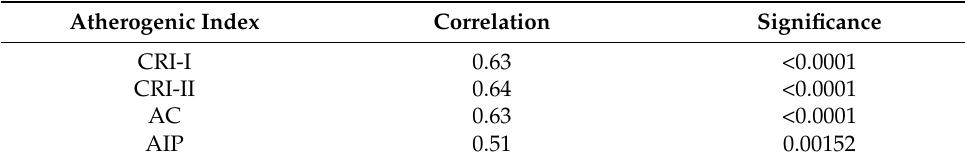
Table 1. Correlations between atherogenic indices and mean aortic tracer uptake.